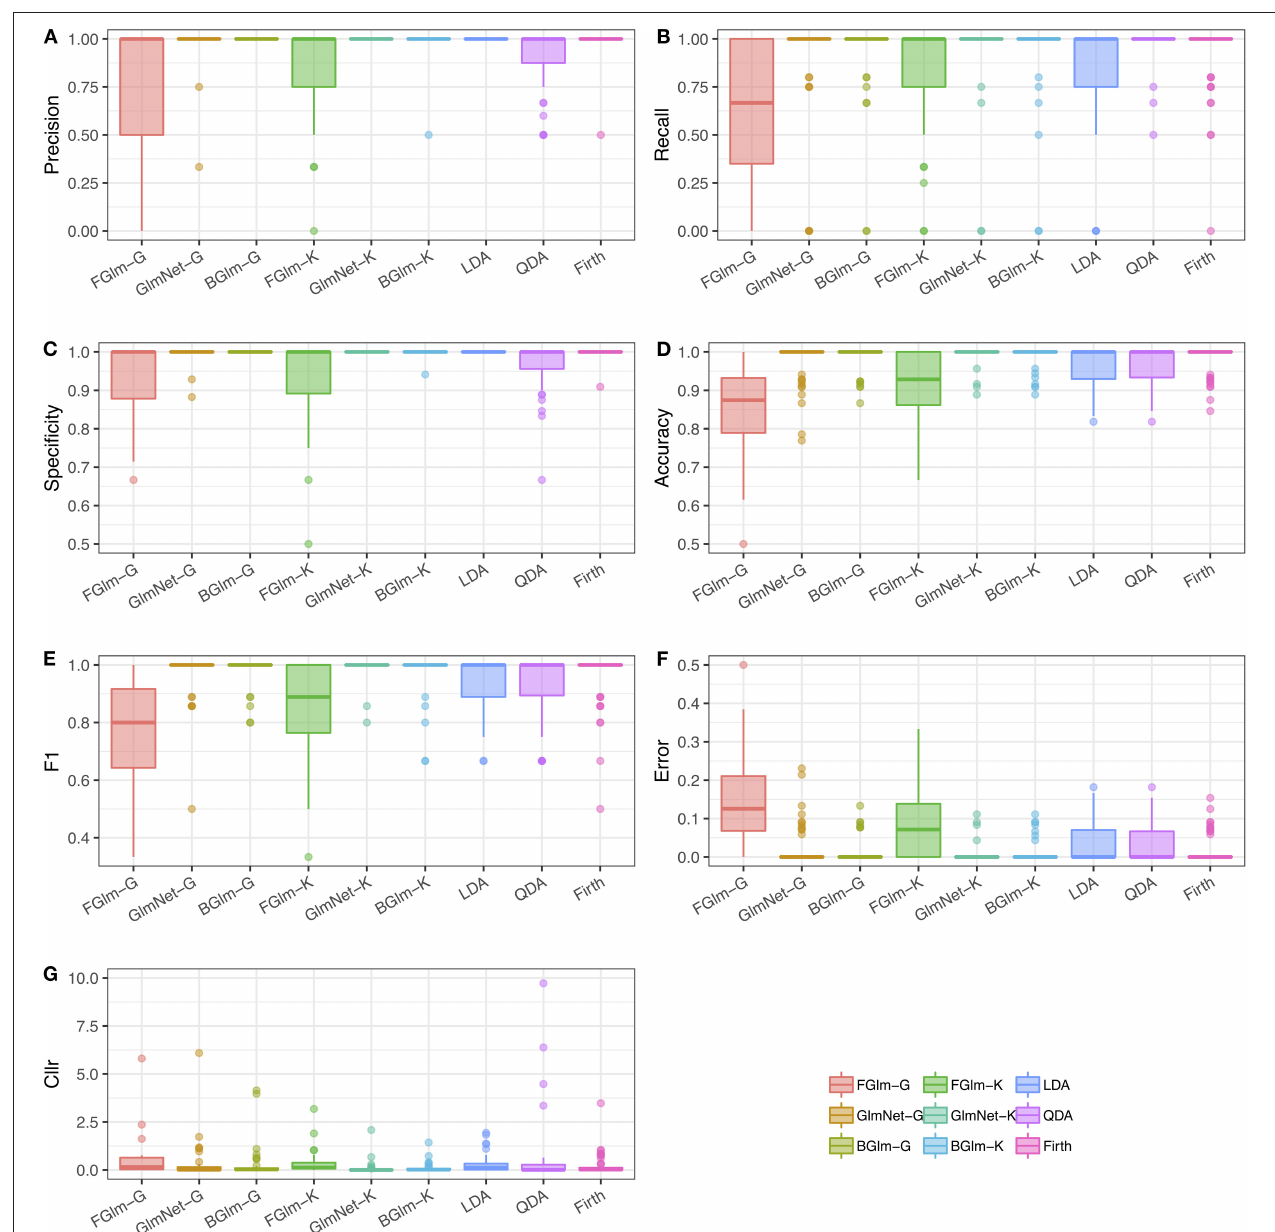
FIGURE 3 | Results of the comparison study between different LR-based and multivariate classification methods. Each figure shows boxplots of different comparison metrics obtained using cross-validation from n cv 50 datasets: precision (A) , recall (B) , specificity (C) , accuracy (D) , F1 (E) , classification error (F) , and C llr (G) (as = defined in Table 2 ). LR methods using a Gaussian density estimation are indicated with suffix “-G,” while LR methods using KDE are indicated with suffix “-K.” LDA, QDA, and Firth GLM have been included for comparison as classification